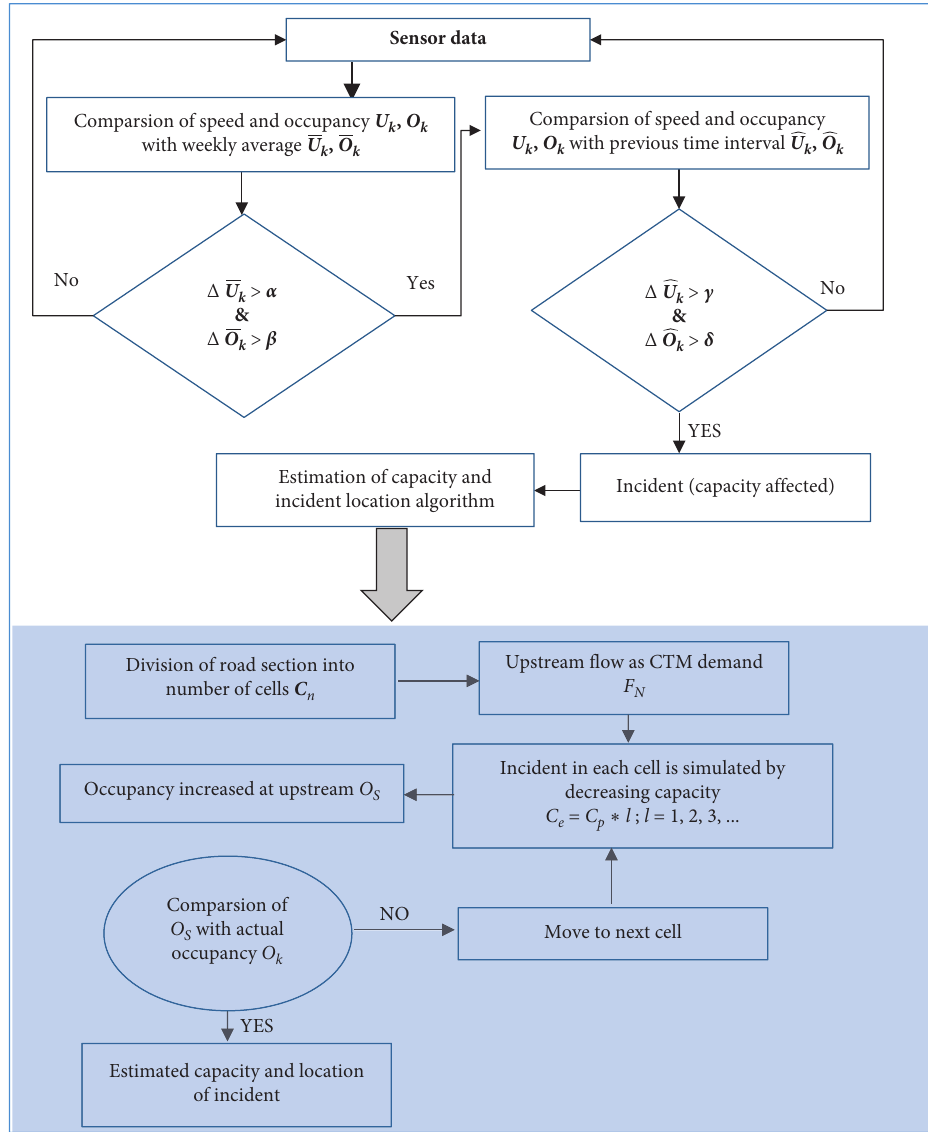
Figure 1: Overall framework of this